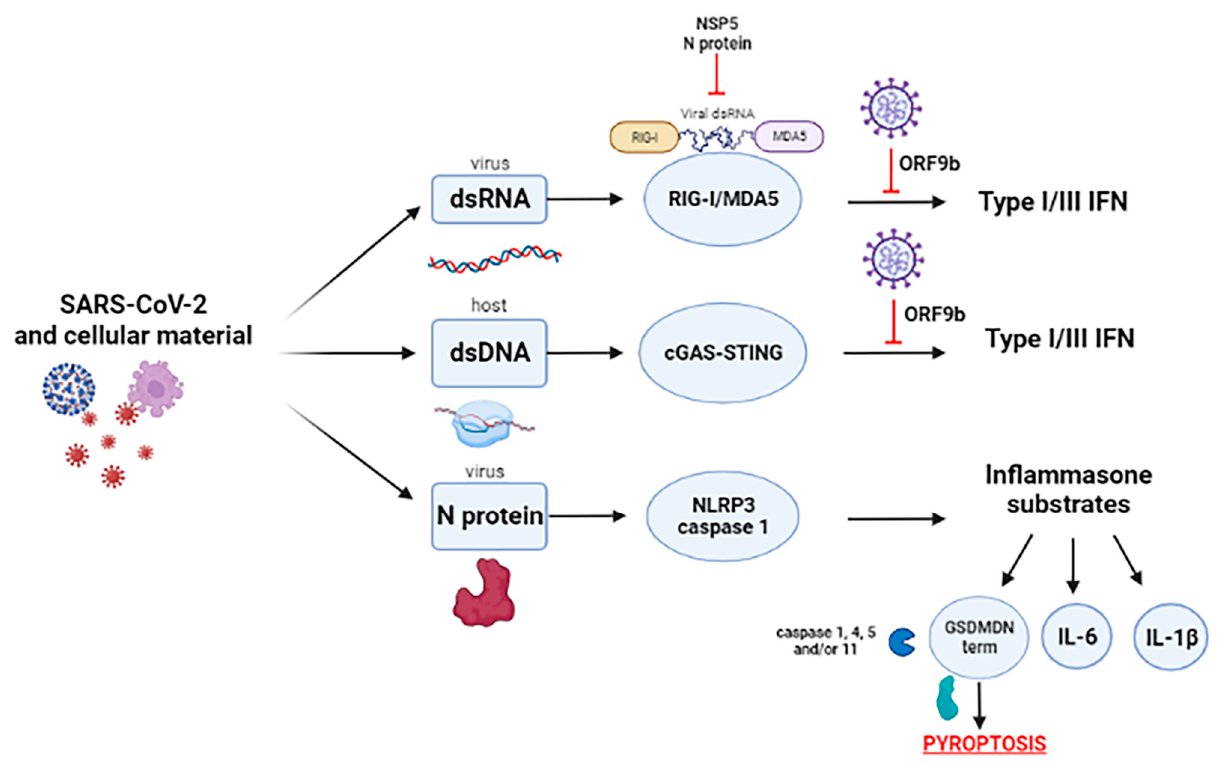
Figure 4. Virus- and host-derived molecules are sensed by several PRRs (Pathogen Recognition Receptors) to induce antiviral and inflammatory responses. SARS-CoV-2 ORF9b and NPS5/N proteins inhibit the activation of type I/III IFNs induced by retinoic acid-inducible gene I (RIG-I)/melanoma differentiation associated protein (MDA5)—mitochondrial antiviral-signaling protein (MAVS) and Cyclic GMP-AMP synthase (cGAS)—Stimulator of Interferon Genes (STING) signaling. SARS-CoV-2 N protein is also able to activate pyrin domain-containing 3 (NLRP3) inflammasome, whose main activation marker is caspase 1, that can lead to the production of IL1B and IL-6 and to pyroptosis, through gastermin D (GSDMD) Nterm cleavage by caspase 1, 4, 5, and/or 11. Once activated, NLRP3 inflammasome causes the release of several proinflammatory cytokines, including IL-6 and IL-1 β (Figure 4) [48], which have been reported to have a key role in the pathogenesis of acute lung injury, included COVID-19, affecting type II alveolar epithelial cells ACE2 expression